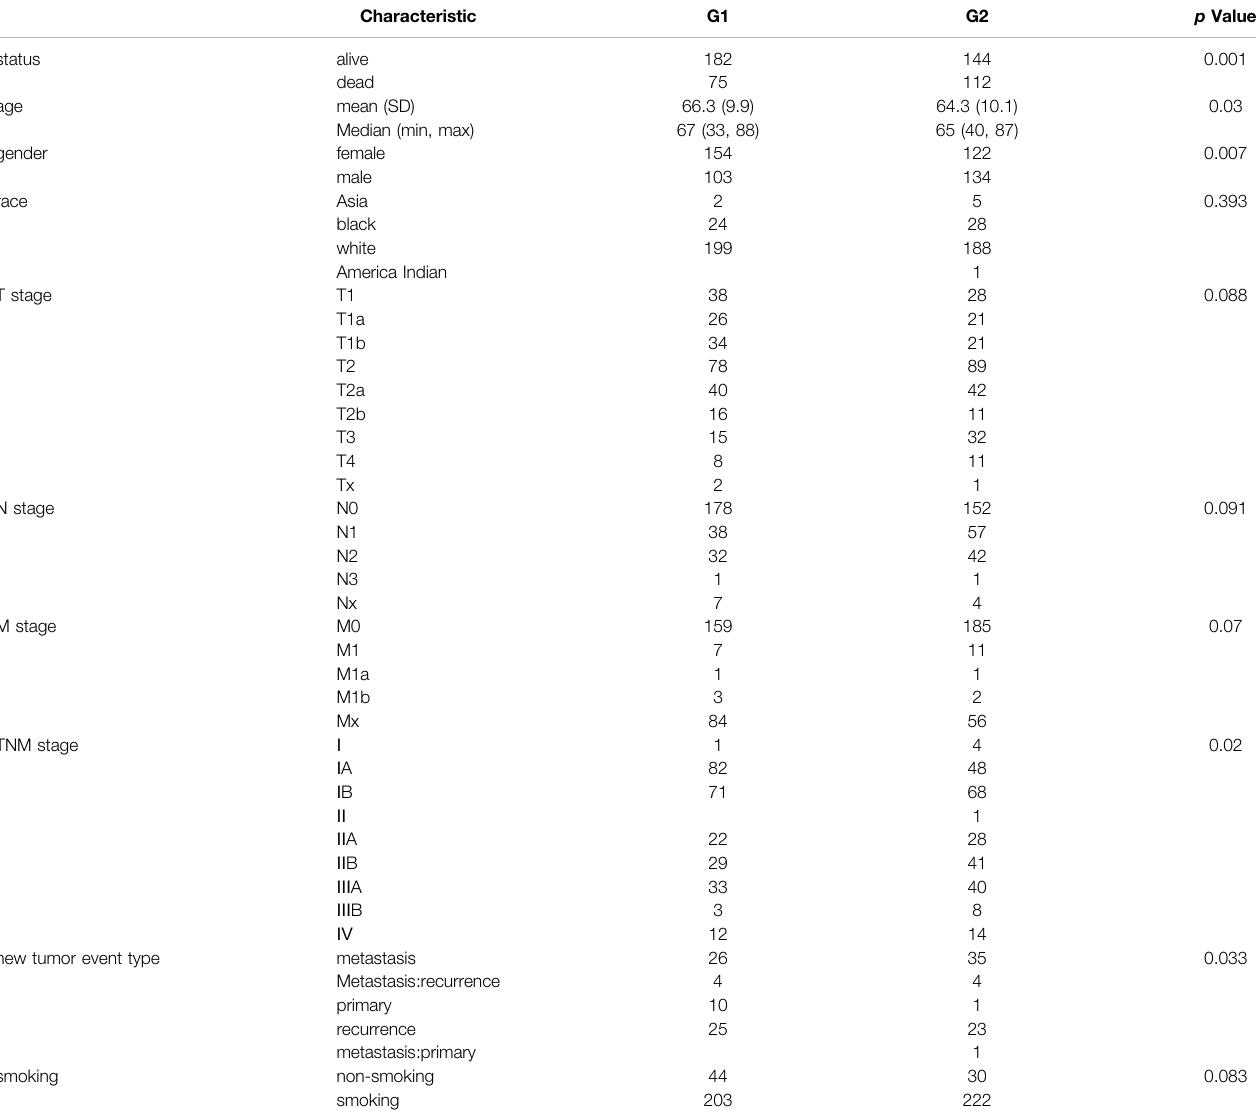
TABLE 1 | Relationship between LRMP expression and clinical variates in LUAD patients.